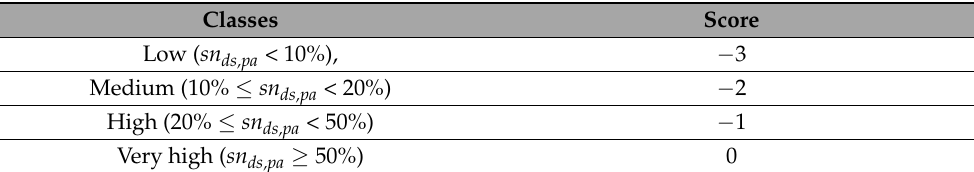
Table 10. SN ds,pa —spatial